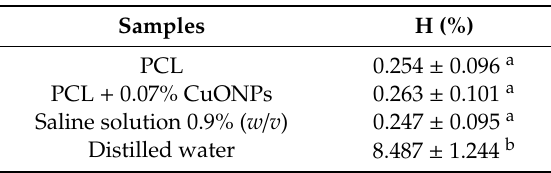
Table 3. Hemolysis caused by neat PCL films and active PCL